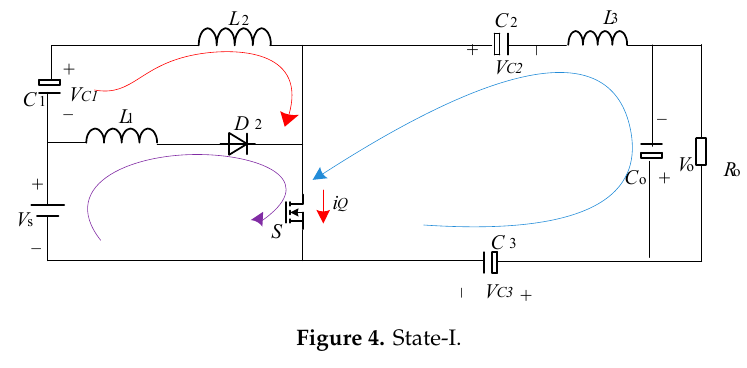
Figure 4. Figure 4. State-I.